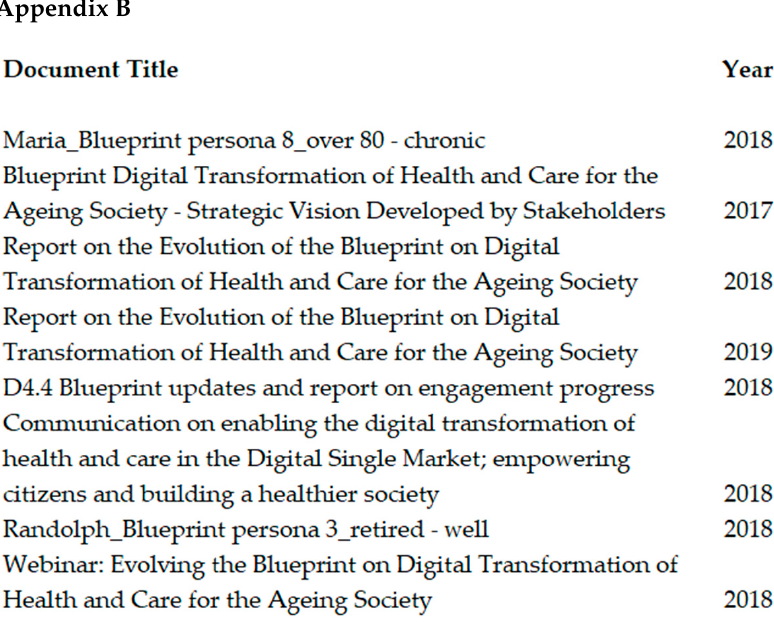
Figure A2. Coded Figure A2. Coded documents.